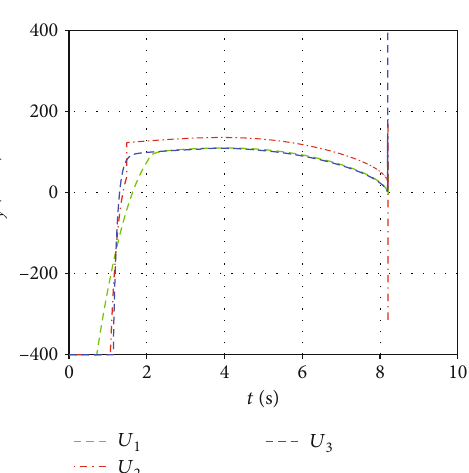
Figure 17: Acceleration instruction u